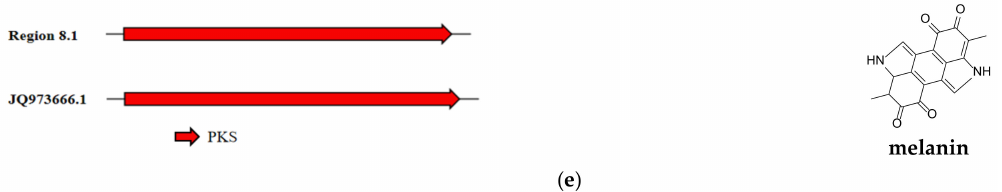
Figure 7. Five identified BGCs with high identity in strain SPS-2 responsible for biosynthesis of ( a ) equisetin, ( b ) betaenones, ( c ) alternariol, ( d ) dimethylcoprogen, and ( e ) melanin. Region 21.2 displayed significant similarity with the BGC of betaenones A–C in Phoma betae (GenBank: LC011911.1). These metabolites exhibited strong inhibitory effects on PKC, CDK4, and EGF-R tyrosine kinases, with the corresponding IC 50 values of 36.0, 11.5, and 10.5 µ M, respectively, and antiangiogenic activity [30]. Genes Bet1 and Bet3 with similarities of 80% and 90%, respectively, are key enzymes in betaenone biosynthesis (Figure 7b, Table S6)